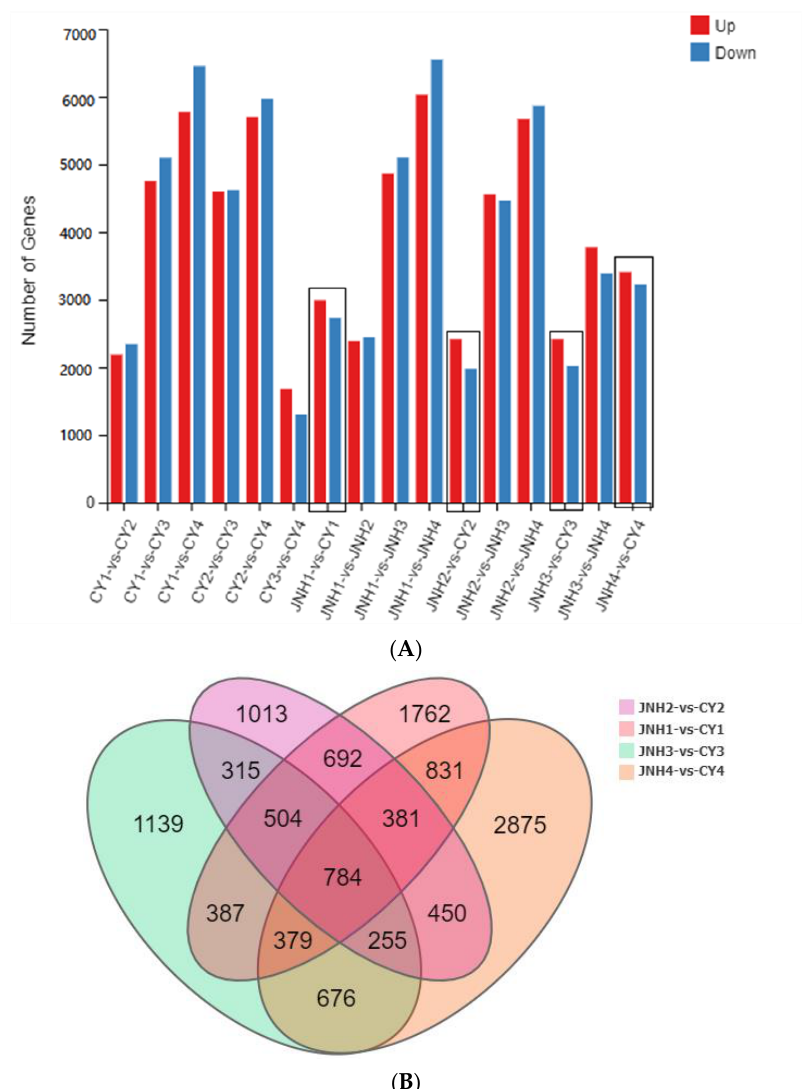
Figure 2. Overview of the differentially expressed genes (DEGs) of JNH and CY fruits at four different ripening stages. ( A ). Number of DEGs between different stages of fruit and between cultivars identified by pairwise comparison (log2 FC ≥ 1 and adjusted FDR < 0.05). The bar chart framed in black boxes were the DEGs between JNH and CY in four specific ripening stages. ( B ). A Venn diagram showing the numbers of the DEGs in four pairwise comparisons.